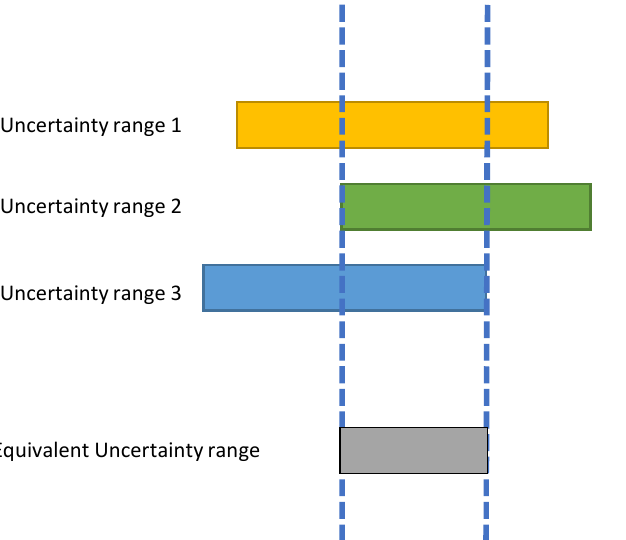
Figure 3. Heuristic decompression to show how the equivalent uncertainty range of a pixel is determined using two neighbors.